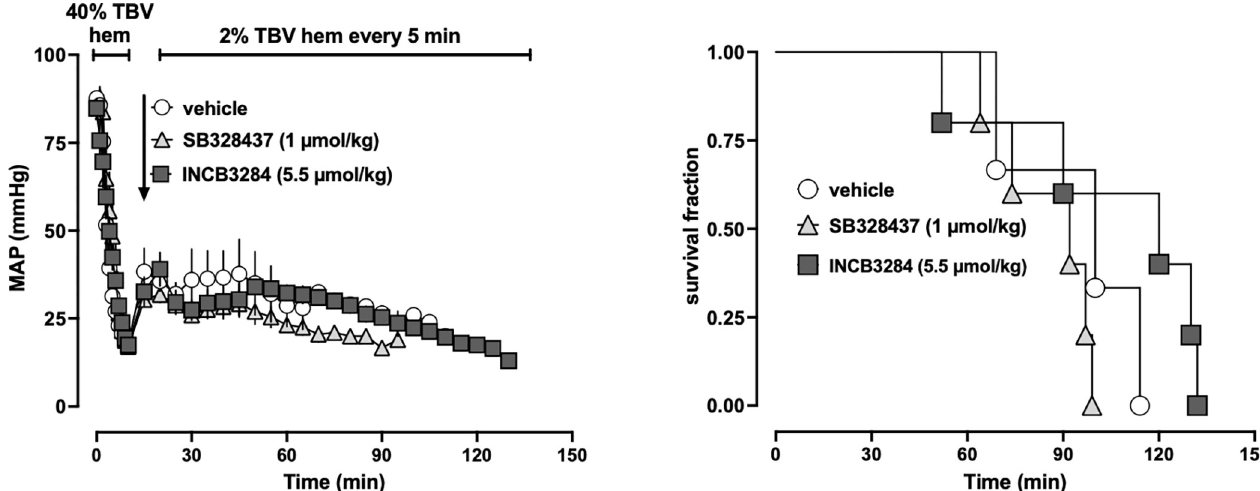
Fig 4. SB328437 and INCB3284 do not affect survival during lethal hemorrhage without fluid resuscitation. All data are mean ± SE. Arrows represent the time point of drug/vehicle injection. Open circles: animals treated with vehicle (n = 3). Grey triangles: animals treated with 1.1 μ mol/kg SB328437 (n = 5). Grey squares: animals treated with 5 μ mol/kg INCB3284 (n = 5). (A) MAP (mmHg). (B) Kaplan-Meier survival curve.